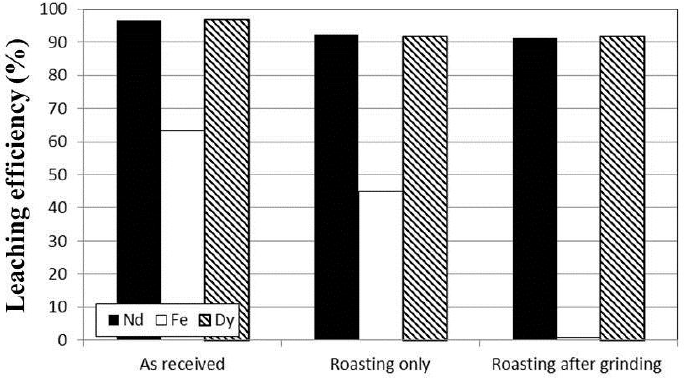
Figure 5. The effect of roasting temperature on the leaching efficiency (Grinding conditions: 550 rpm in rotational speed, 5 cm 3 in water addition, 30 min in grinding time, 15 in stoichiometric molar ratio).